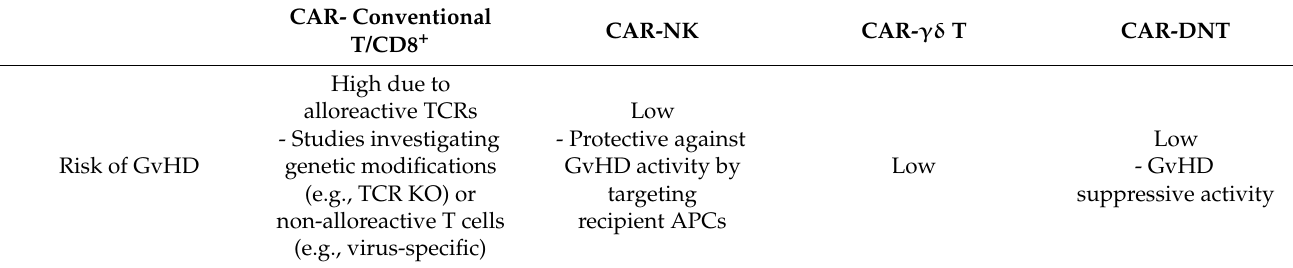
Table 4. Advantages and limitations of conventional T cells, NK cells, γδ T cells, and DNT cells as a vehicle for